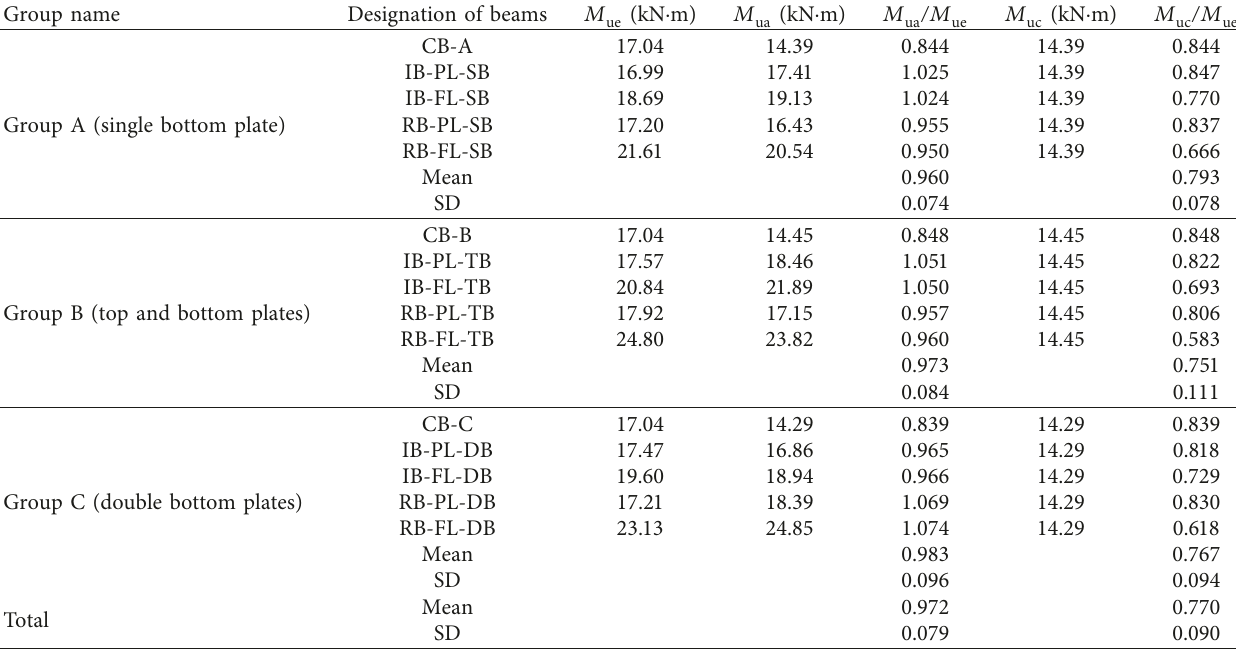
Table 9: Comparisons of experimental moment capacities against the theoretical model and design code values. Group